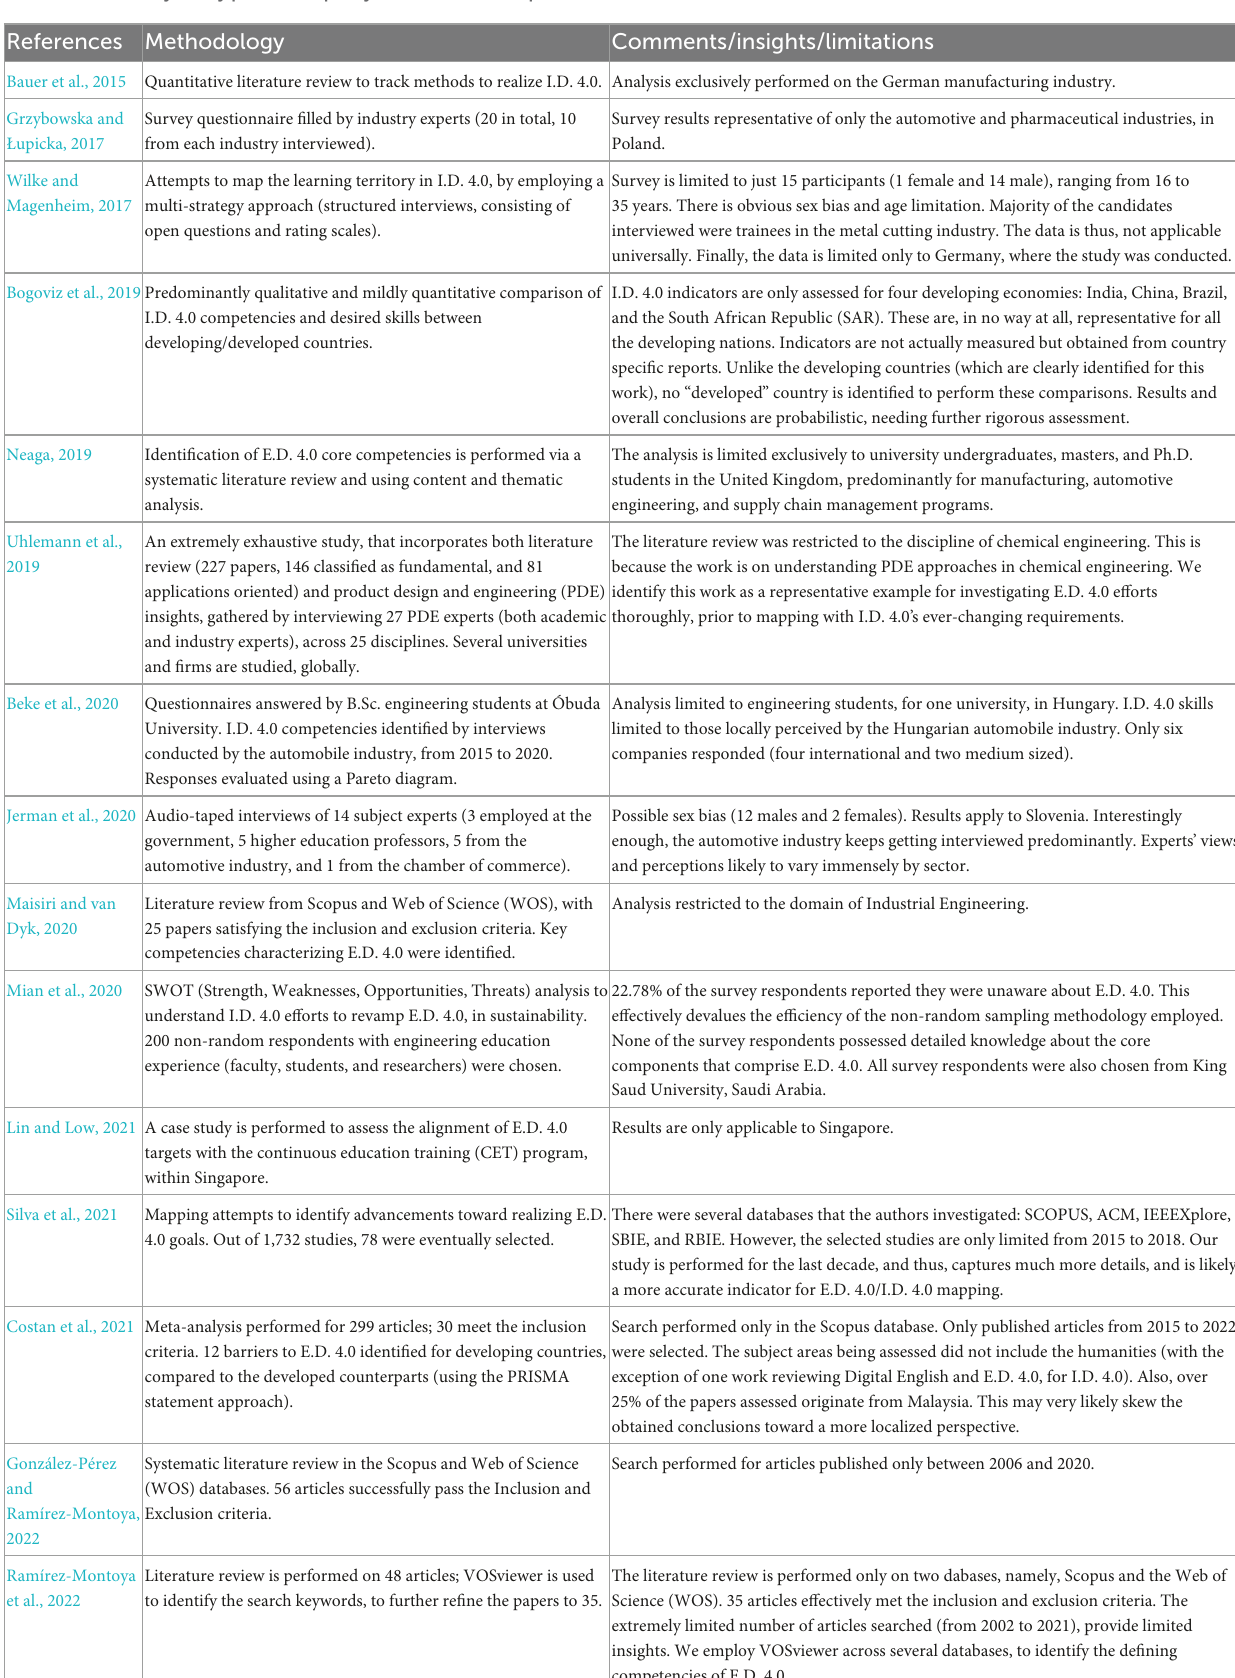
TABLE 1 A summary of key prior attempts by researchers, to map E.D. 4.0 to I.D. 4.0, and